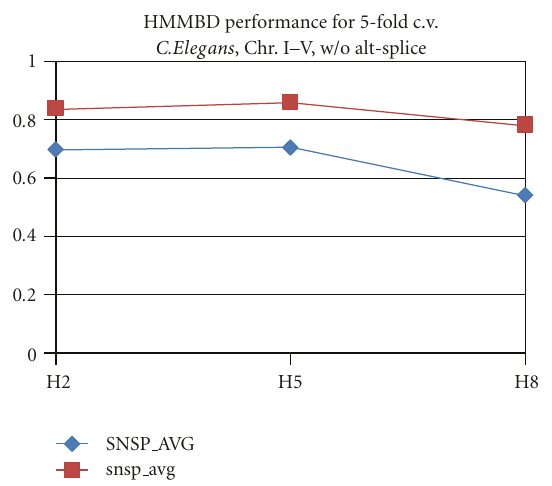
Figure 6: Nucleotide (red) and exon (blue) accuracy results for Markov models of order: 2, 5, and 8, using the 5-bin HMMBD (where the AC value of the five folds is averaged in what is shown).